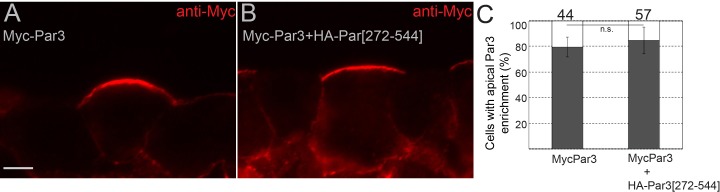
Par3[272-544] construct does not affect Par3 localization.(A–C) Four animal blastomeres of 16 cell embryos were injected with Myc-Par3 RNA, 70 pg with or without 0.5 ng of HA-Par3[272-544] RNA. Injected embryos were cultured until stage 11, cryosectioned and immunostained for Myc (A, B). (A, B) Myc-Par3 with is enriched at the apical membrane. Scale bar, 10 µm. (C) Quantification of data in (A, C) shown as mean frequencies ± s. d. of superficial ectoderm cells with apically enriched Myc-Par3. Total numbers of scored cells are shown above each bar; 13 to 26 cells were scored per embryo with three embryos taken for each experimental condition, statistical difference determined by two-tailed Student’s t-test was not significant, p>0.05. Data are representative of two experiments.